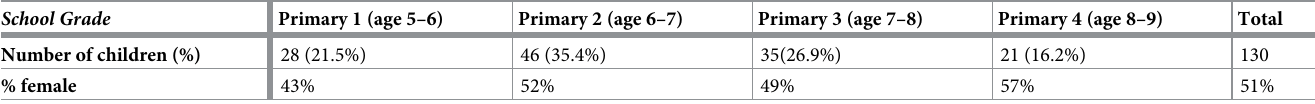
Table 1. School grade, gender and age spread (%) of participating children. School